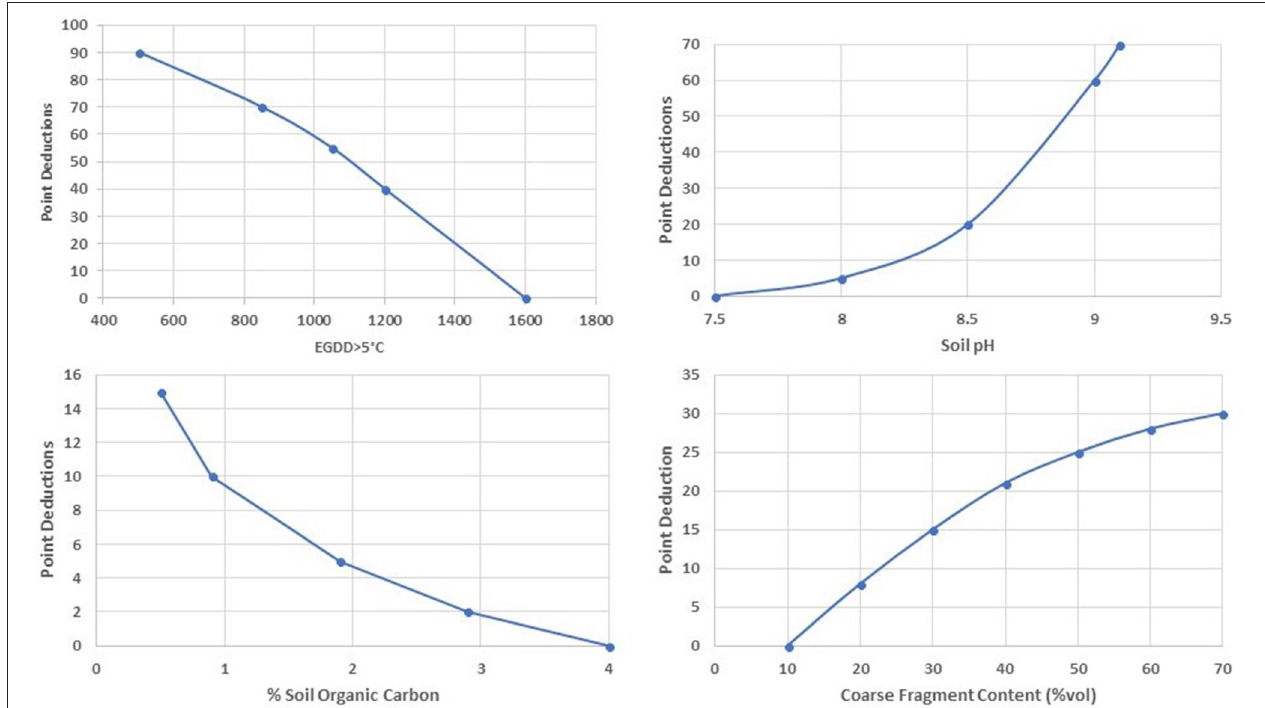
FIGURE 1 | Selected climate and soil parameter deduction curves for spring seeded small grains from Agronomic Interpretations Working Group (1995). Different parameters are set to differing deduction point ranges. Effective growing degree days (EGDD > 5 ◦ C) are a key determinant of climate suitability. A value of < 900 would result in at least a 70-point deduction, enough to generate an unsuited class rating for grain production. Similarly, a soil pH > 9.0 alone would generate an unsuitable soil rating but sub-optimal soil organic carbon or coarse fragment content deductions typically result in suitability class reductions.